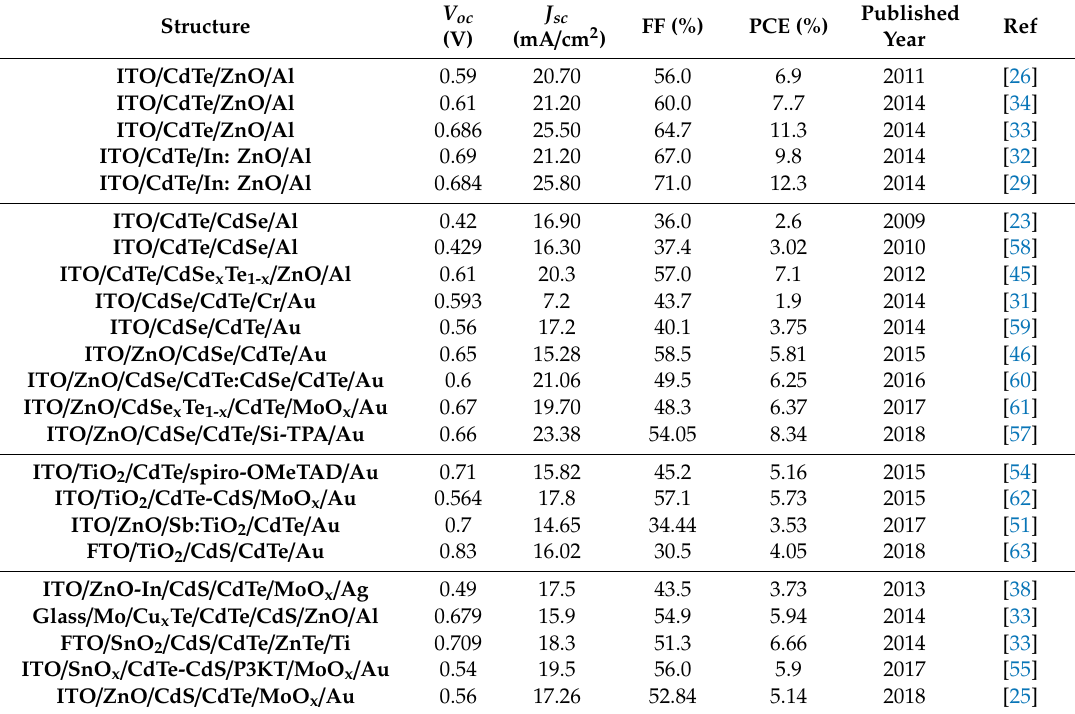
Table 1. Selected performance parameters of CdTe NC solar cells fabricated via solution